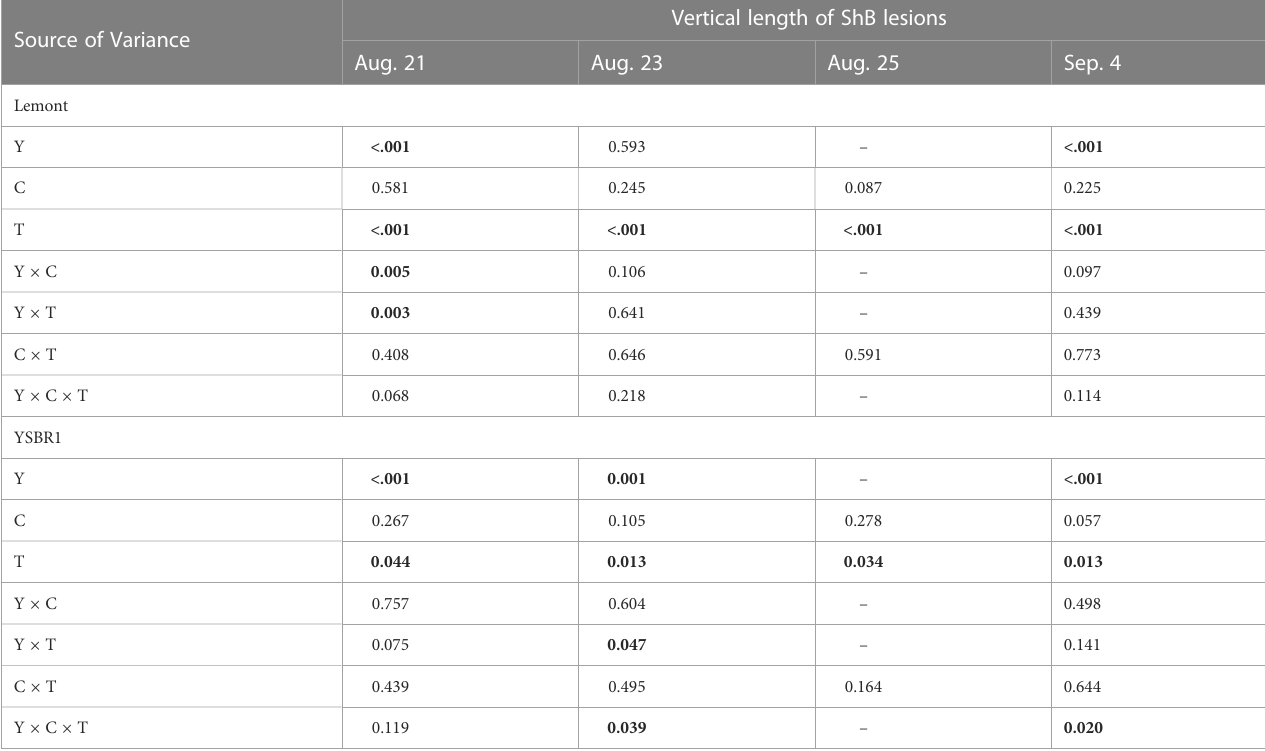
TABLE 2 Summary of analysis of variance (ANOVA) for the in fl uence of year, CO 2 and temperature on the dynamic change of vertical length of ShB lesions for cvs Lemont and YSBR1 in 2020 and 2021 a .